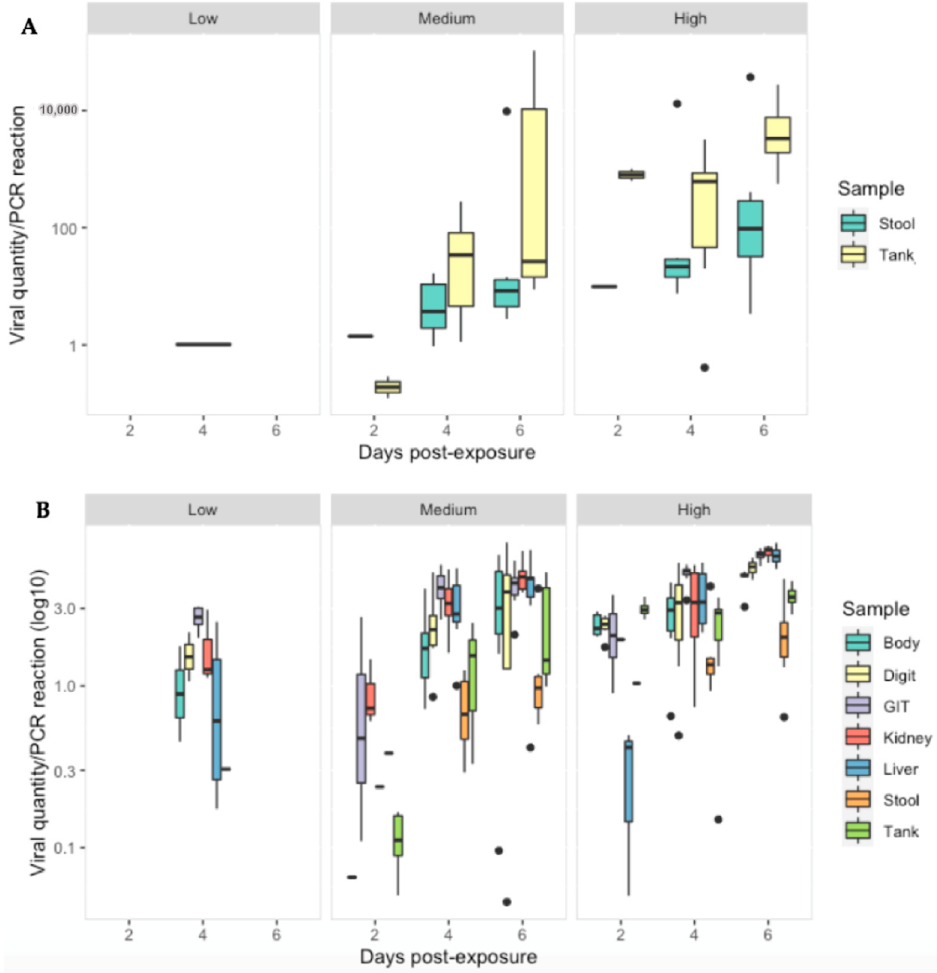
Figure 7. Viral quantity per PCR reaction for: ( A ) stool and tank swabs and ( B ) Body, digit and tank swabs, GIT, kidney and liver tissue obtained from R. temporaria from all treatment groups at 2, 4 and 6 days-post exposure to ranavirus. Black dots indicate outliers.